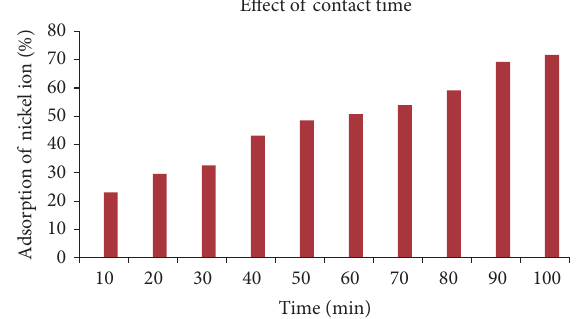
(cid:49)(cid:80)(cid:84)(cid:74)(cid:85)(cid:74)(cid:80)(cid:79) (cid:60) (cid:1250) (cid:19)(cid:2480) (cid:62) (cid:9)(cid:68)(cid:80)(cid:81)(cid:81)(cid:70)(cid:83) (cid:9)(cid:36)(cid:86)(cid:10)(cid:10) F 4: XRD analysis for ZLRC.